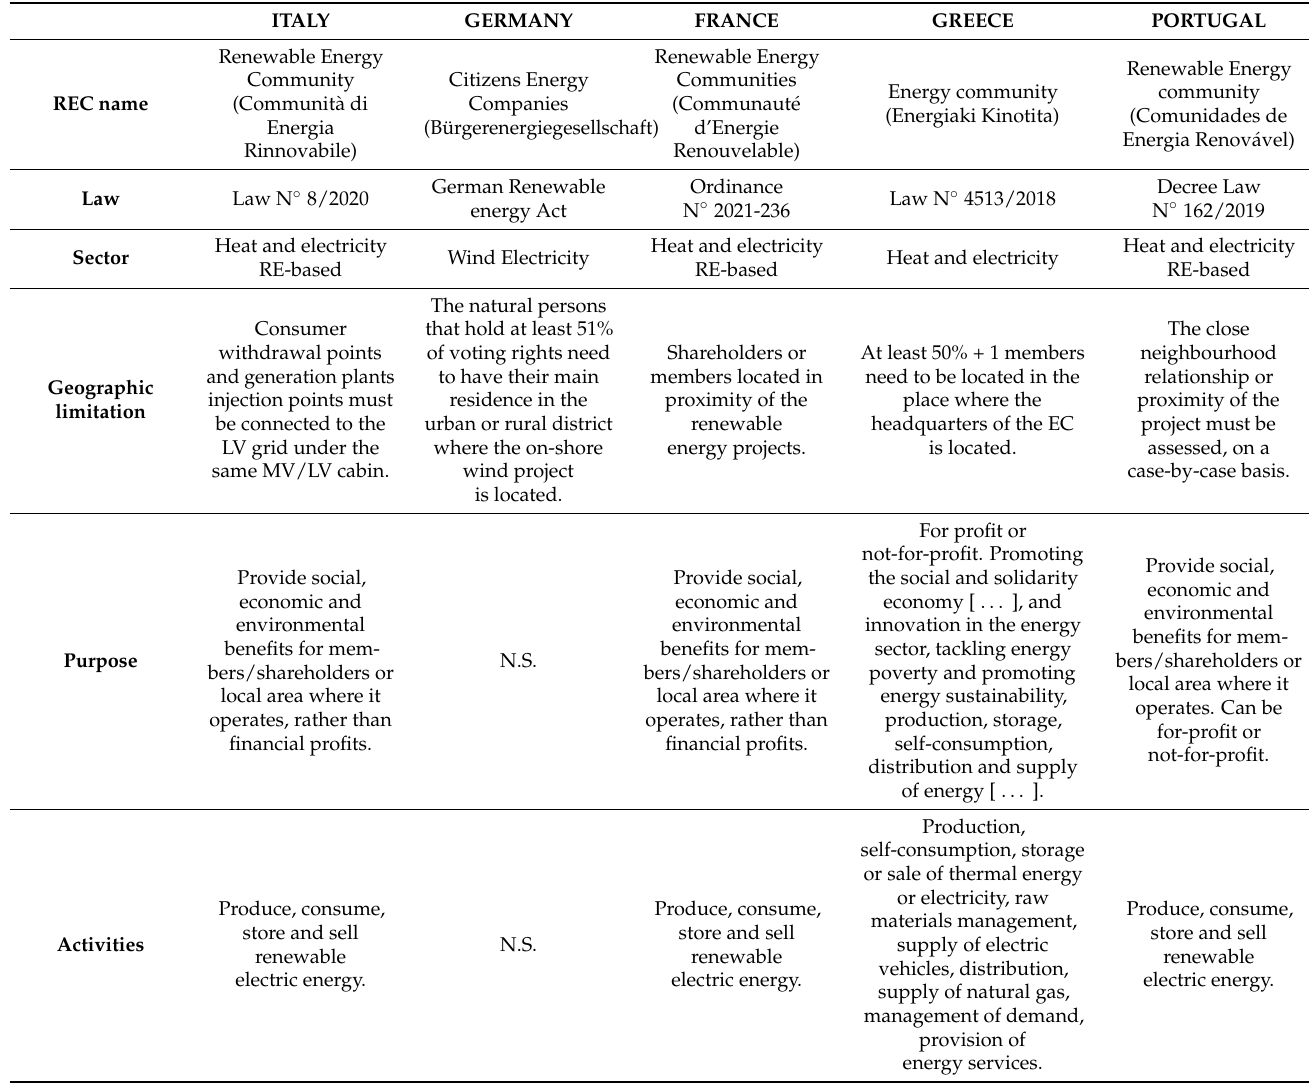
Table 2. Energy Communities transposition progress